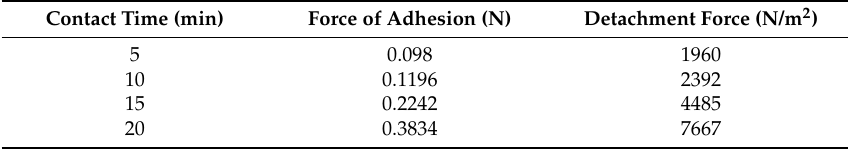
Table 1. Force of adhesion and detachment force of the patch after different contact time on porcine buccal mucosa ( n = 3).